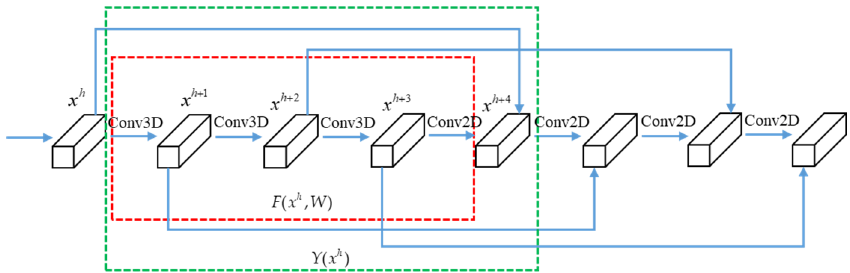
Figure 2. 3D–2D alternating residual block. Legend: Conv3D, 3D convolution; Conv2D, 2D convolution.